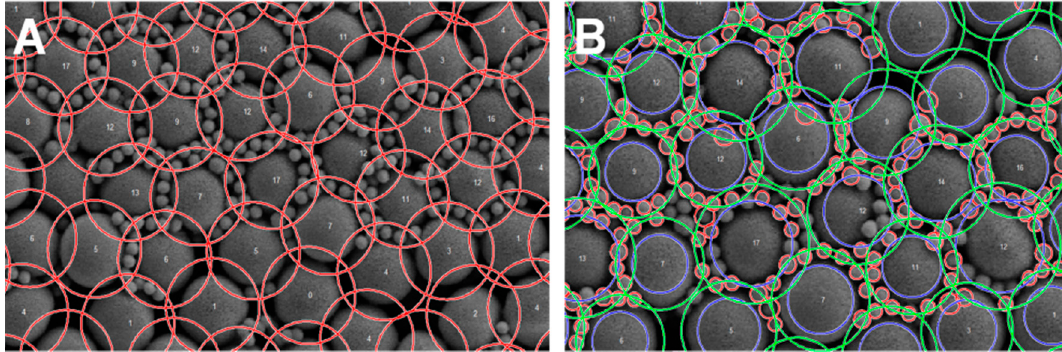
Figure 3. ( A ) The large particles are detected with the defined area surrounding them where small particle placement is allowed in red; ( B ) Detection of small particles within the confined regions surrounding the large